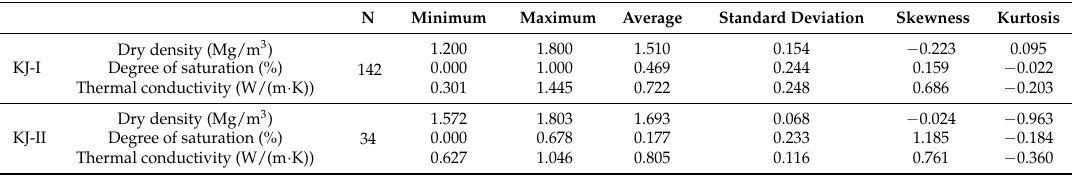
Table 3. Summary of descriptive statistical